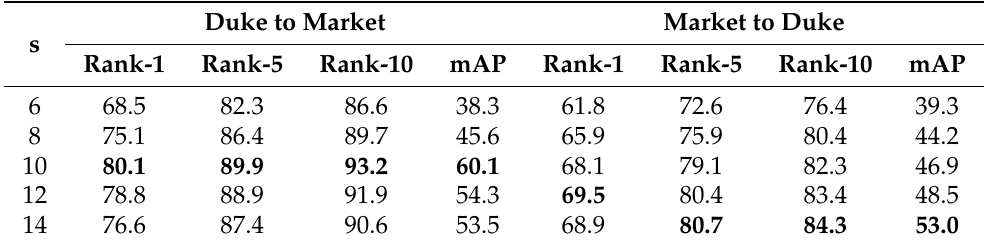
Table 1. Evaluation with different scale factor s